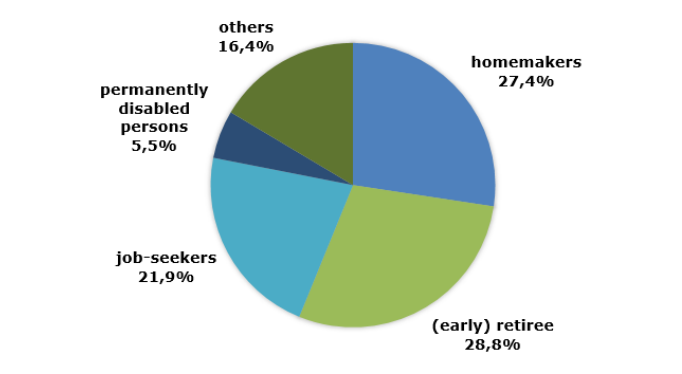
Figure 2: Composition of Non-Employed People in the population survey had three children and more. Furthermore, the employed people were younger (average of 46.8 years), more often parents (+11.9 percentage points) and lived less alone (-10.5 percentage points). In addition to that, the majority of those who lived together with their children had two children (compared with mostly one child of the